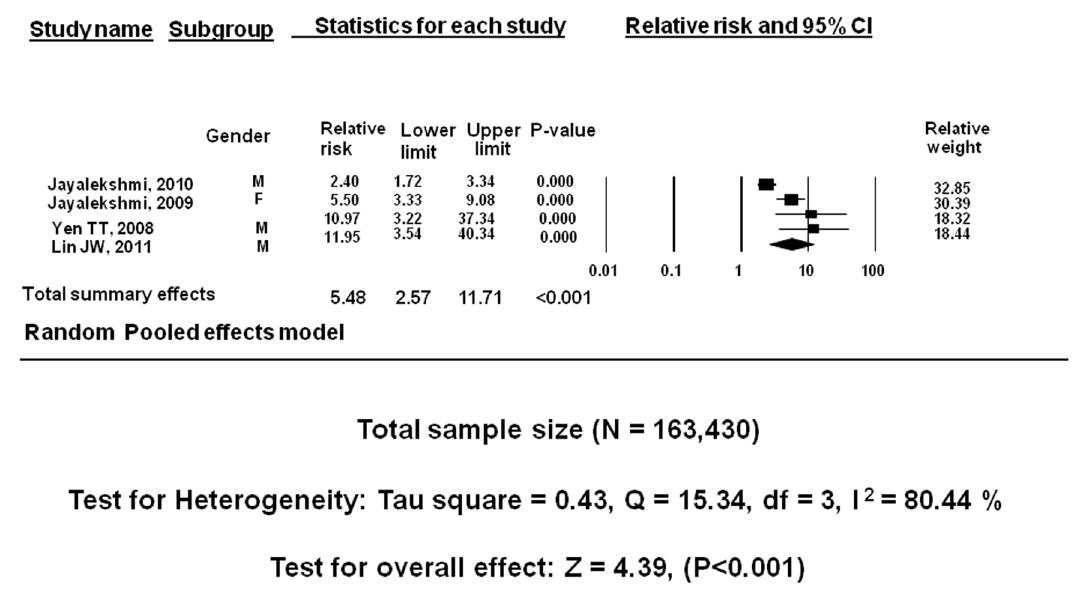
Figure 4. Meta-analysis of cohort studies: ST NOS use and incidence of oral cancer.